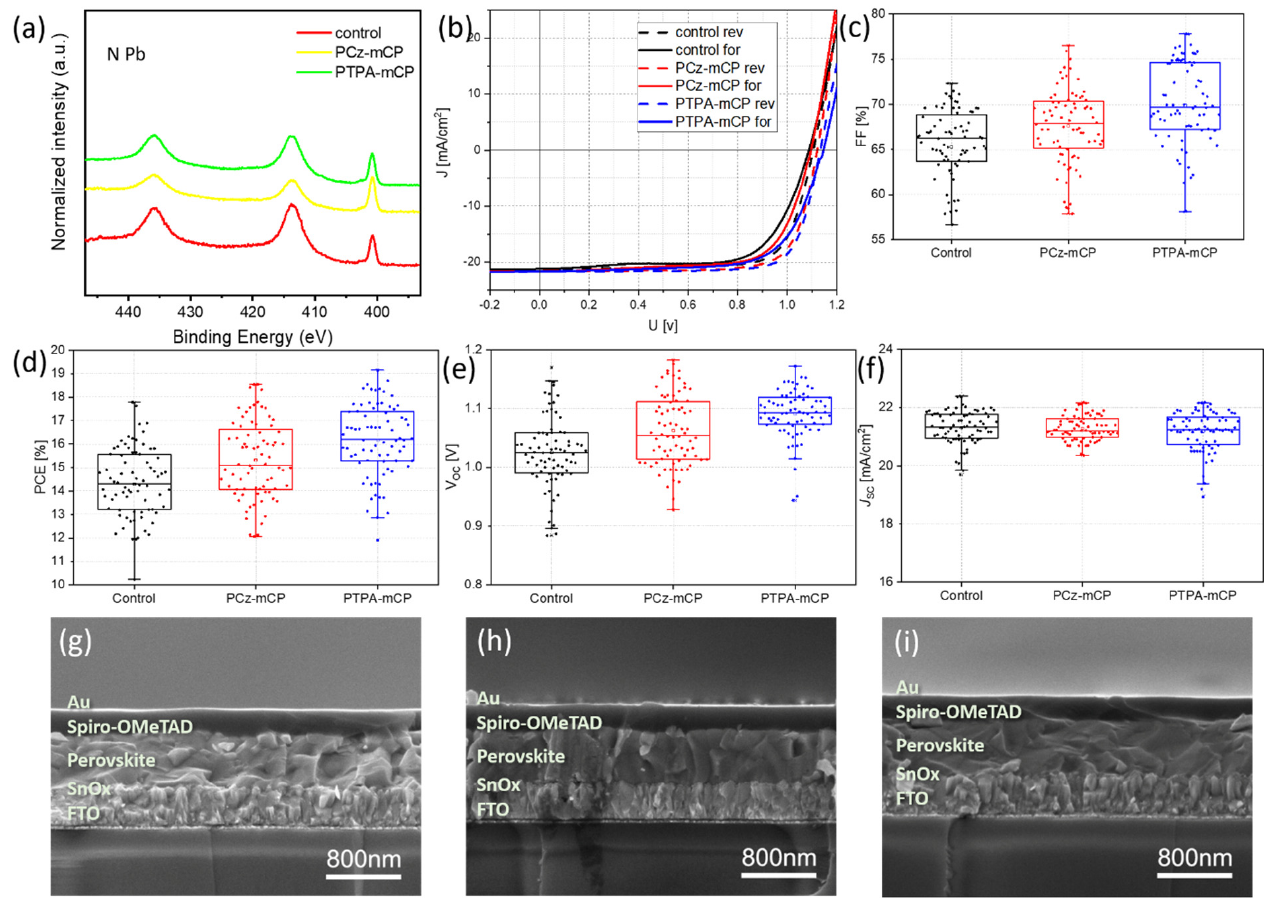
Figure 4. ( a ) XPS spectra of Pb 4d and N 1s and ( b ) J – V curves of the comparison between the control film and PCz-mCP and PTPA-mCP modified perovskite films. Box chart of the ( c ) FF, ( d ) PCE, ( e ) V OC , and ( f ) J SC of different devices. Cross-sectional SEM images of ( g ) control, ( h ) PCz-mCP, and ( i ) PTPA-mCP modified devices.